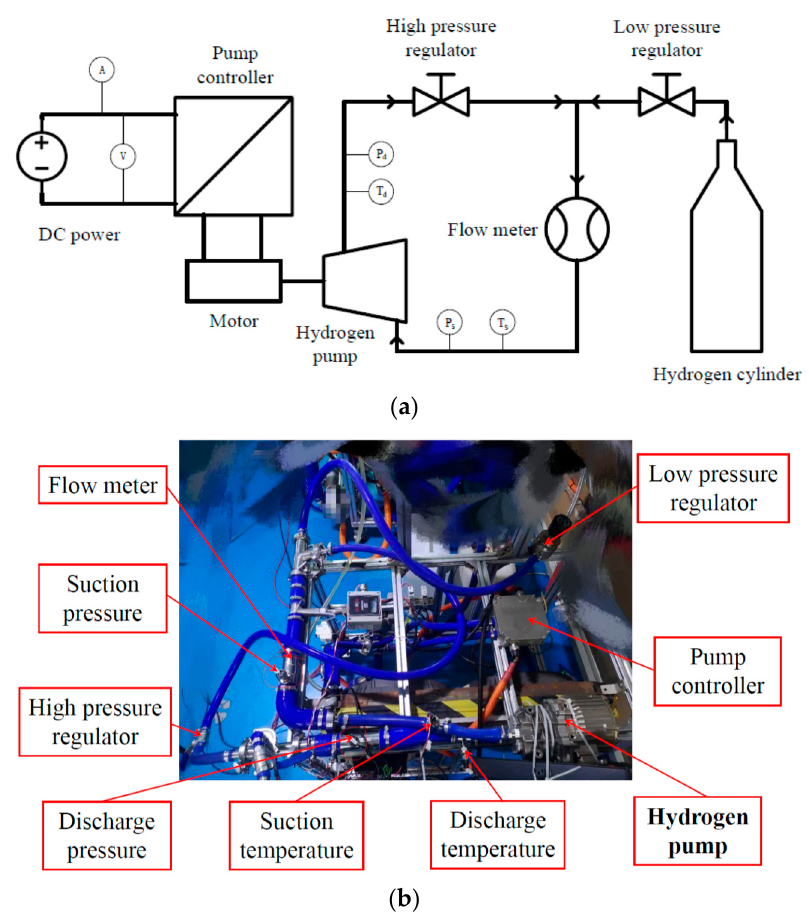
Figure 4. Test rig for Roots pump working with hydrogen : ( a ) schematic diagram; and ( b ) photo of the test rig.